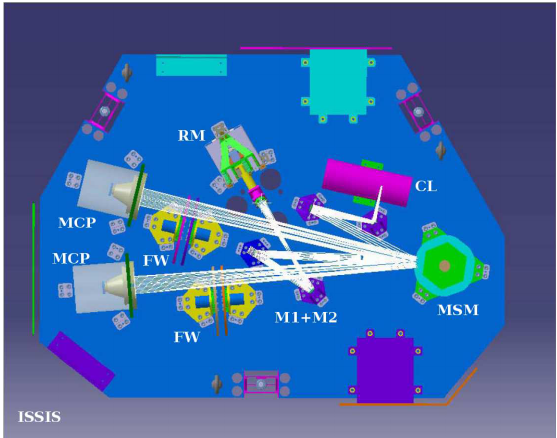
Figure 3: The layout of the Imaging and Slitless Spec- troscopy Instrument (ISSIS). The acronyms mark the location of: detectors (MCP), filter wheels (FW), pick- up mirror mechanism (RM), calibration lamp (CL), mode selector mechanism (MSM) and the mirrors M1 and